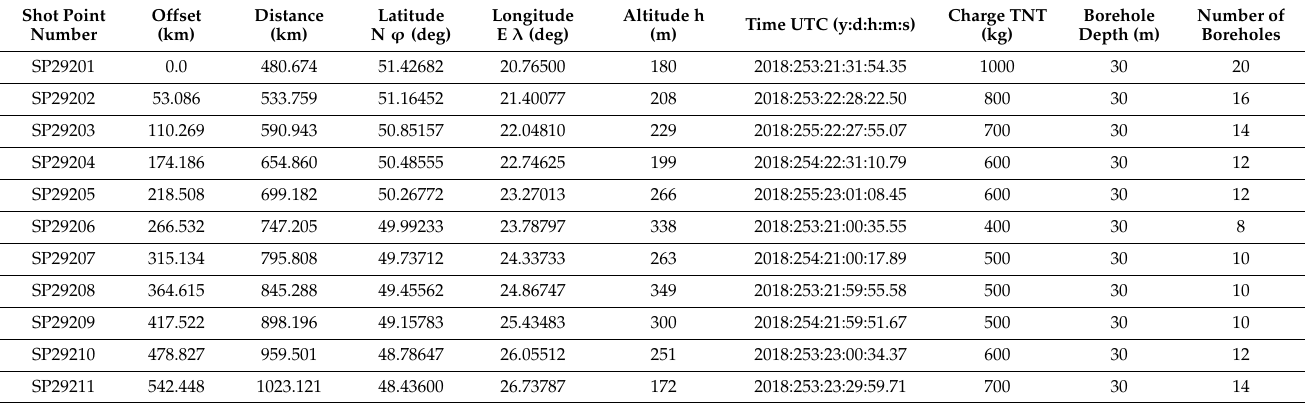
Table 1. Locations and other parameters of explosive sources used along the TTZ-South